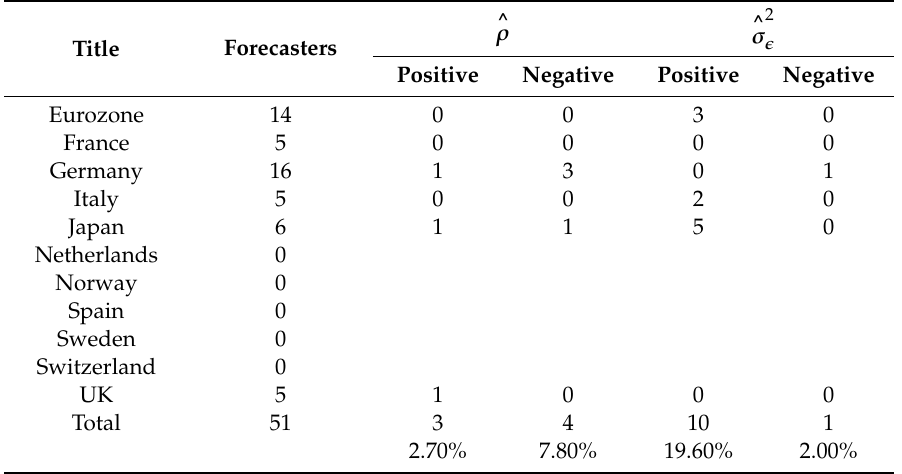
Table 6. Results for regression model (1) for other countries or regions, unemployment. The counts concern the number of cases with 10% significant estimation